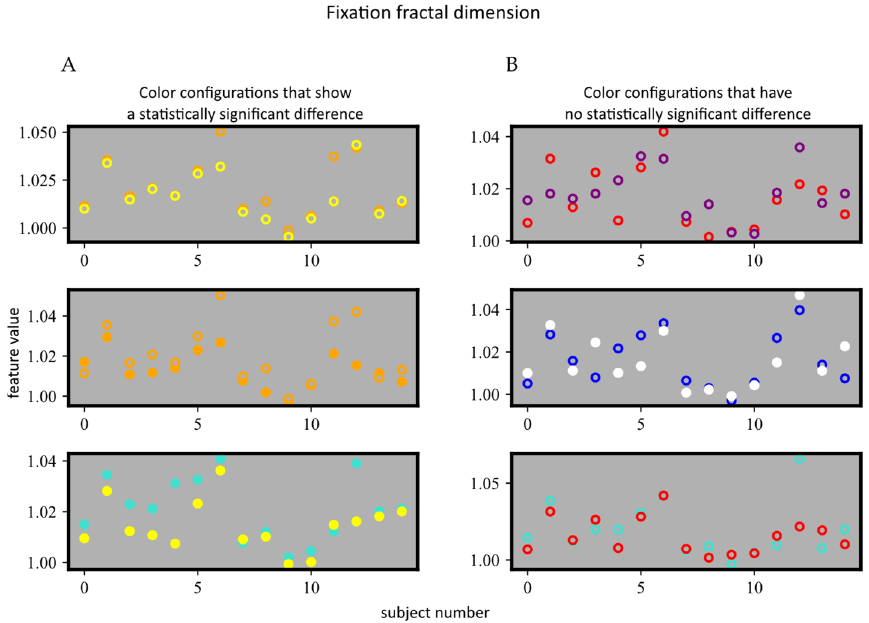
Figure 5. The visualization of data for all dyslexic subjects, for the three color configurations that ( A ) show a statistically significant difference and ( B ) show no statistical difference. Dots represent the background color configurations, and circles represent the overlay color configurations.